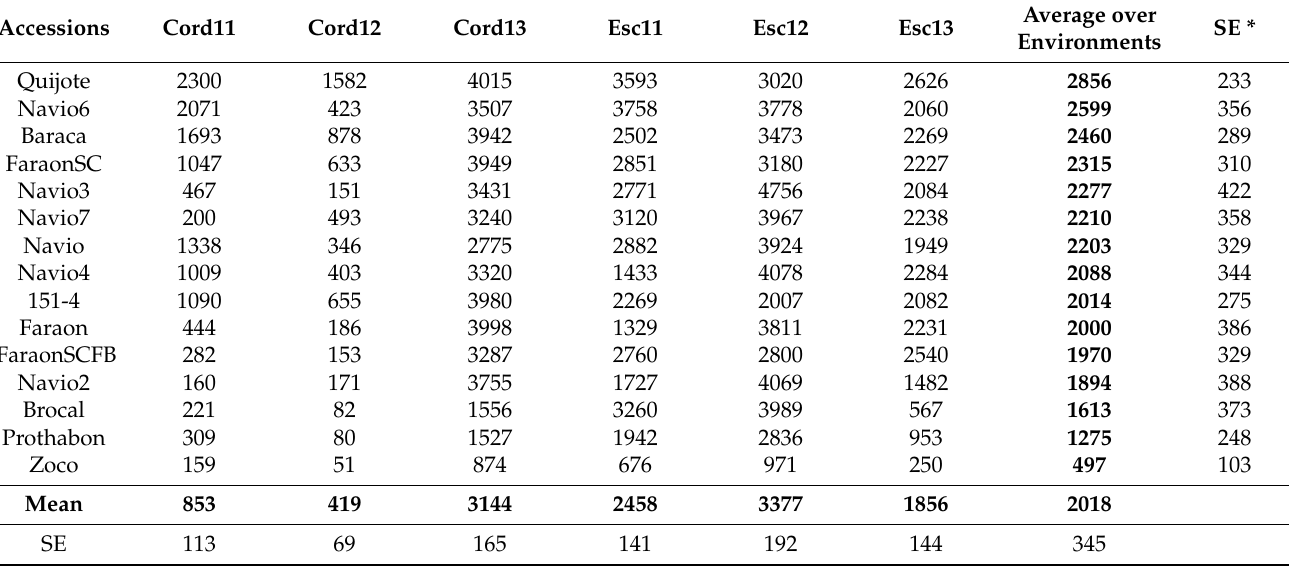
Table 3. Grain yield (kg/ha) of 15 faba bean accessions grown at six location–year